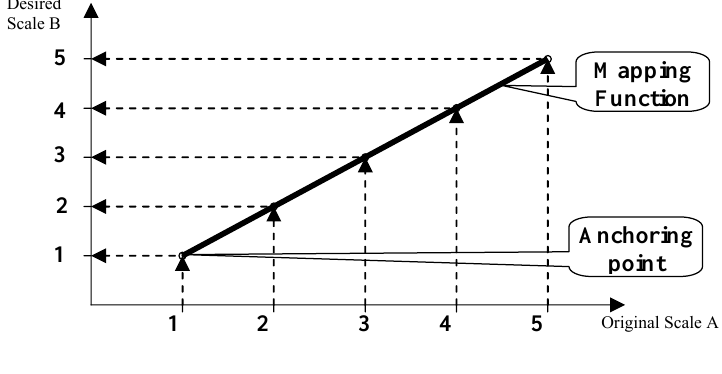
Fig. 2. Linear mapping from one scale to